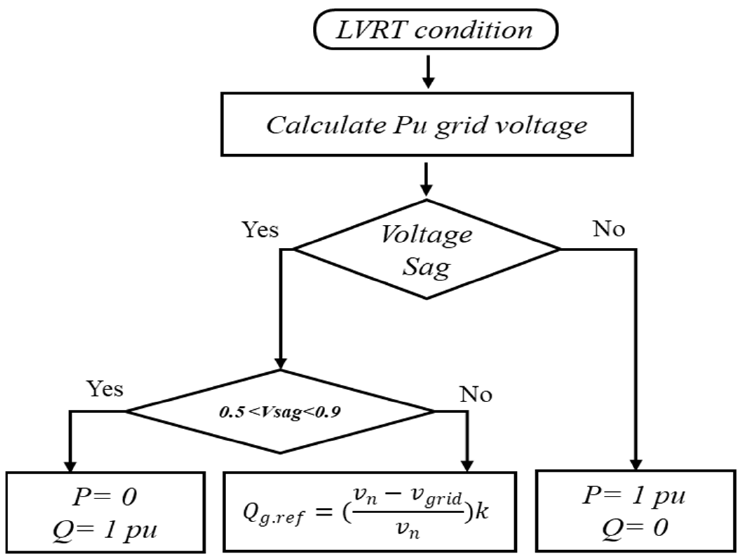
Figure 7. Flowchart of LVRT Scheme.